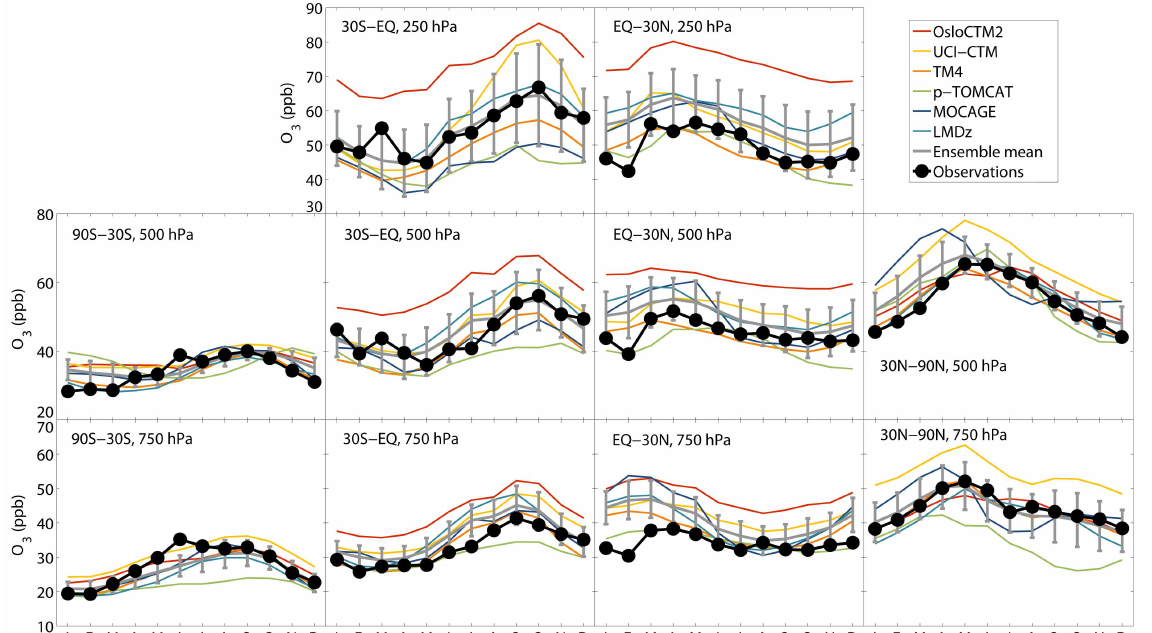
Fig. A1. Comparison of the monthly mean ozone observations (black line with dots) from Logan (1999) with the model ensemble mean and standard deviation (grey line with error bars), and the individual model results (see legend for color codes) at different latitude bands (from left to right: 90 ◦ S–30 ◦ S, 30 ◦ S–EQ, EQ–30 ◦ N, 30 ◦ N–90 ◦ N) and different pressure levels (from top to bottom: 250hPa, 500hPa, 750hPa) for the 2003 model simulations. For comparison, the figure has been made similar to Fig. 2 in the multi-model study by Stevenson et al.